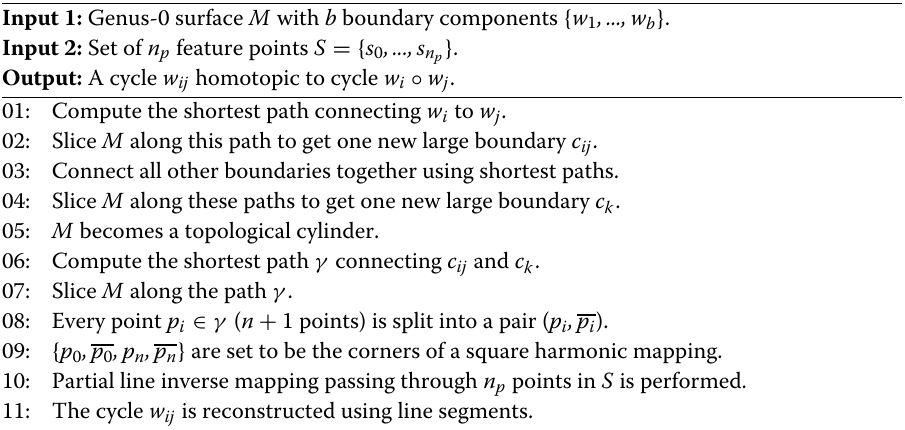
Algorithm 3 Feature homotopic cycle